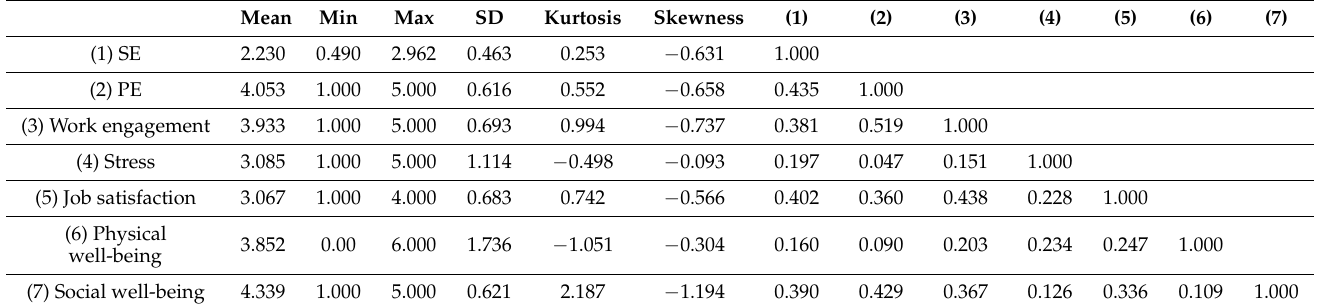
Table 2. Descriptive statistics and correlations between constructs.